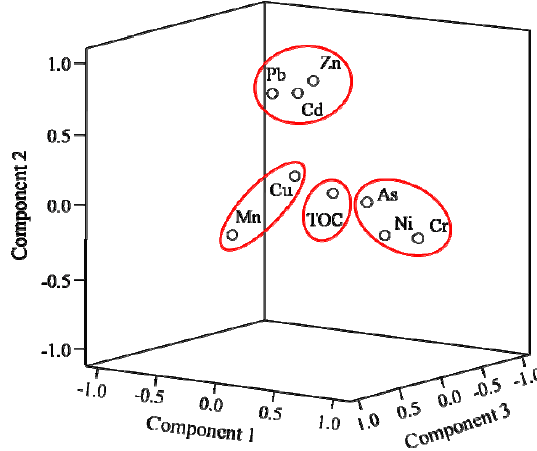
Figure 3. 3-D PCA loading plot for 8 HMs and TOC.